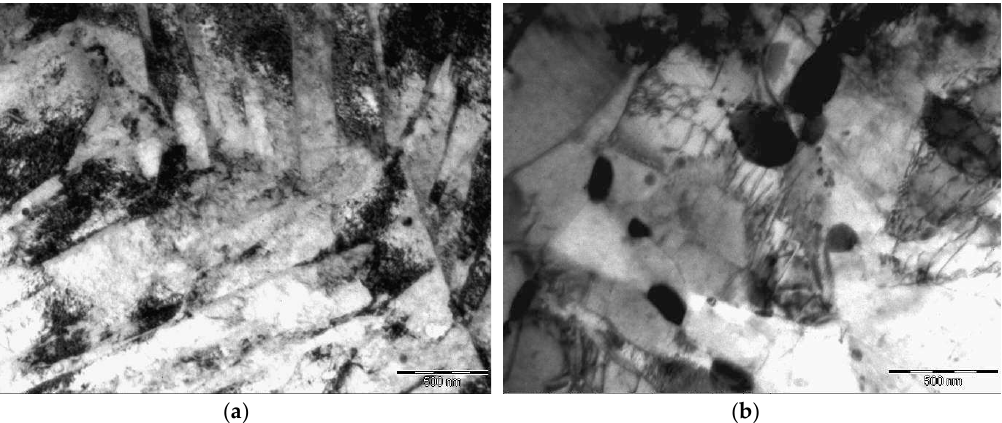
Figure 1. Bright-field transmission electron microscopy (TEM) images of Grade 91 microstructure after quenching and tempering at: ( a ) 500 °C; ( b ) 800 °C